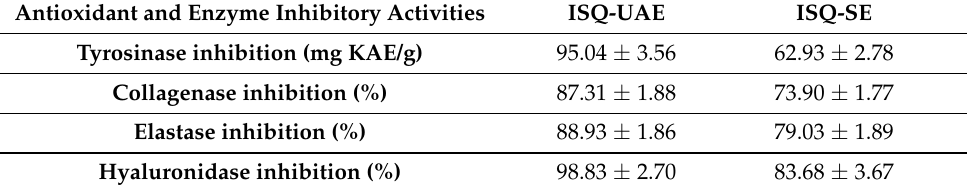
Table 4. Cont. Antioxidant and Enzyme Inhibitory